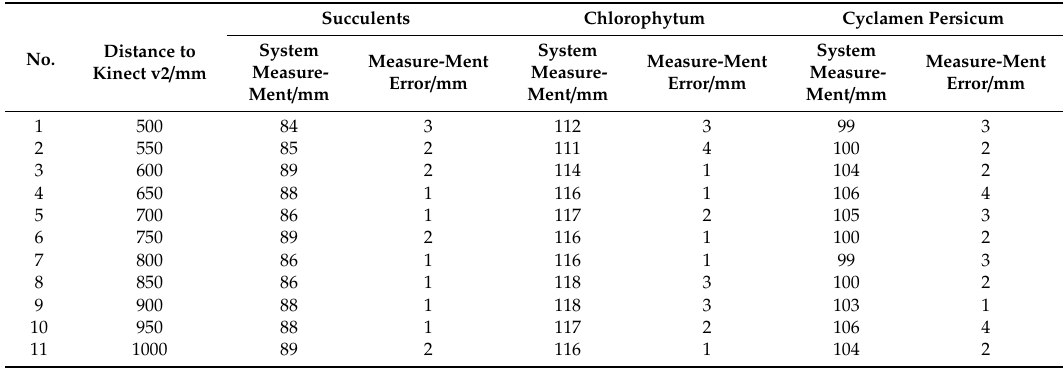
Figure 14. Three different plant sizes and shapes in validation experiment, ( a ) Succulents, ( b ) Chlorophytum, ( c ) Cyclamen persicum, and their manual measurement heights: 87 mm, 115 mm, 102 mm, respectively. Table 4. Plant height precision measurement results of three different sized plants with different distances to the Kinect v2.